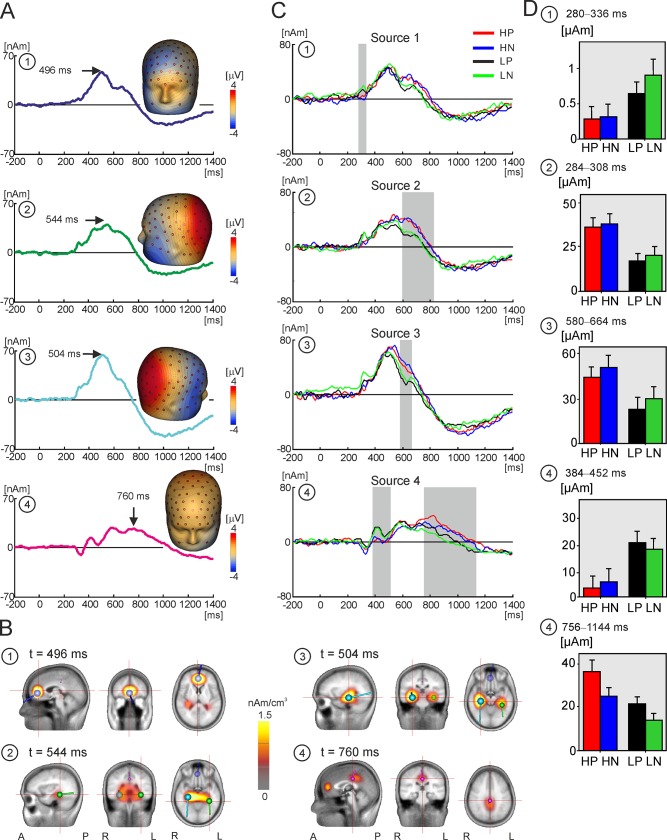
Source dipole model and source waveforms.
A. The grand average waveforms of four equivalent source dipoles and their isopotential line maps. The isopotential maps were plotted at the temporal maxima, highlighted with an arrow and labelled with the latency value. The source dipoles are numbered from 1 to 4. B. CLARA source activation maps and source dipole locations of four cortical sources. The peak latency of each source corresponds to that in panel A. A = anterior, P = posterior, L = left, R = right. The numbering of dipoles corresponds to that in A. 1 = blue dipole, 2 = green dipole, 3 = ice blue dipole, 4 = magenta dipole. C. The grand average waveforms of four equivalent source dipoles, numbered from 1 to 4, in high and low pain catastrophising groups during viewing pain and non-pain scenes. Red line = pain photographs in High-Cat group, blue line = non-pain photographs in High-Cat group, black line = pain photographs in Low-Cat group, green line = non-pain photographs in Low-Cat group. The grey-filled rectangles indicate epochs used in statistical analyses. D. Bar chart of mean source activations and standard error bars for each condition during time windows of interest identified by permutation analysis (grey rectangles).